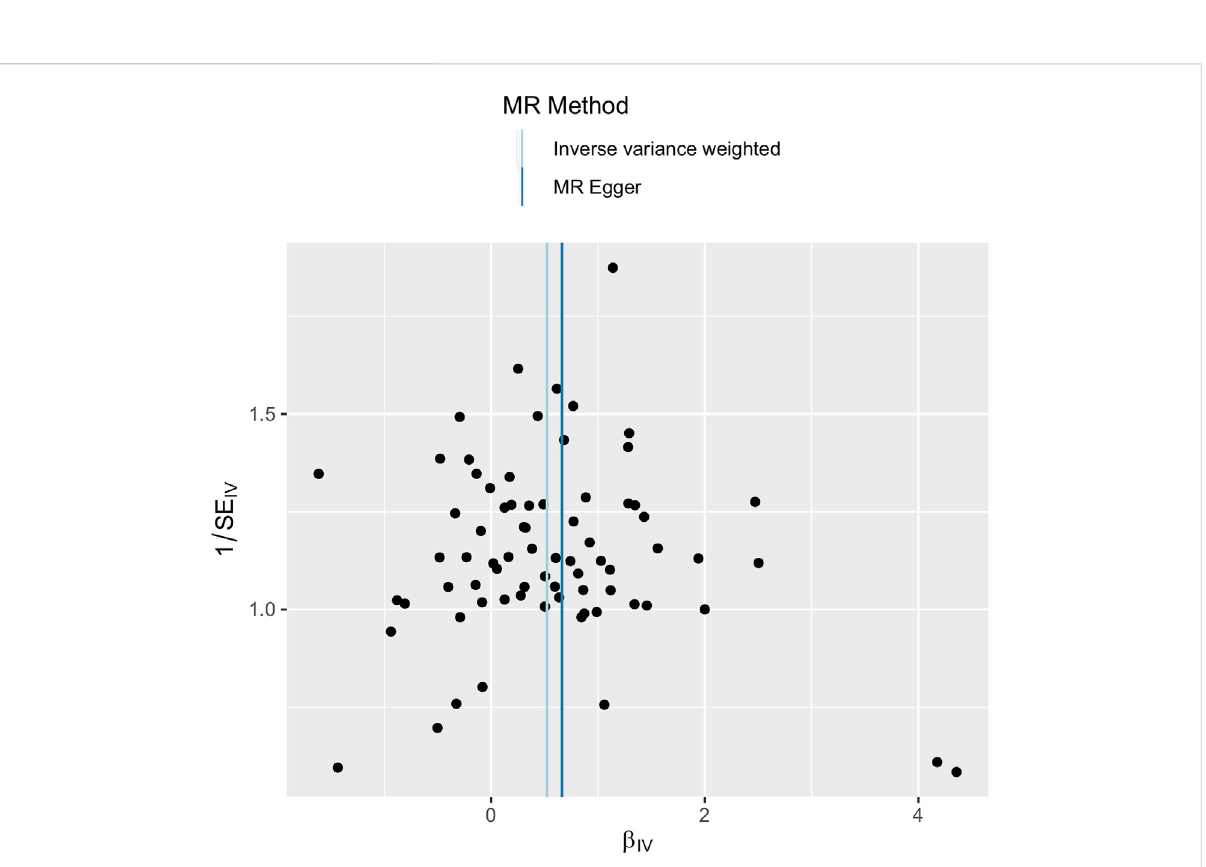
FIGURE 4 Funnel plot of SNPs used in MR of depression on ED. Abbreviations: SNP, single-nucleotide polymorphism; β , the effect size; SE, the standard error of the effect size; IVs, instrumental variables; ED, erectile dysfunction; MR, Mendelian